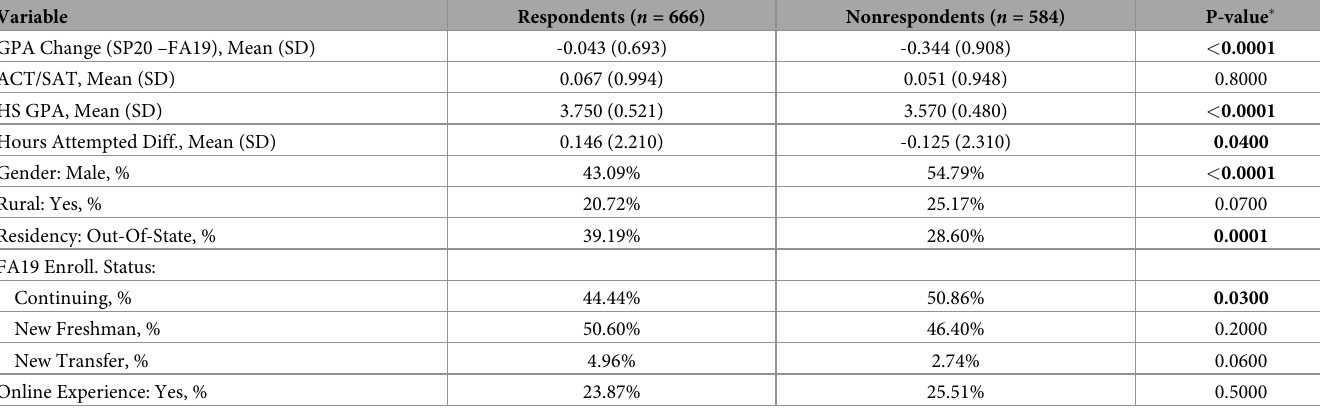
Table 5. Summary statistics of survey respondents and nonrespondents on data available from institutional records.